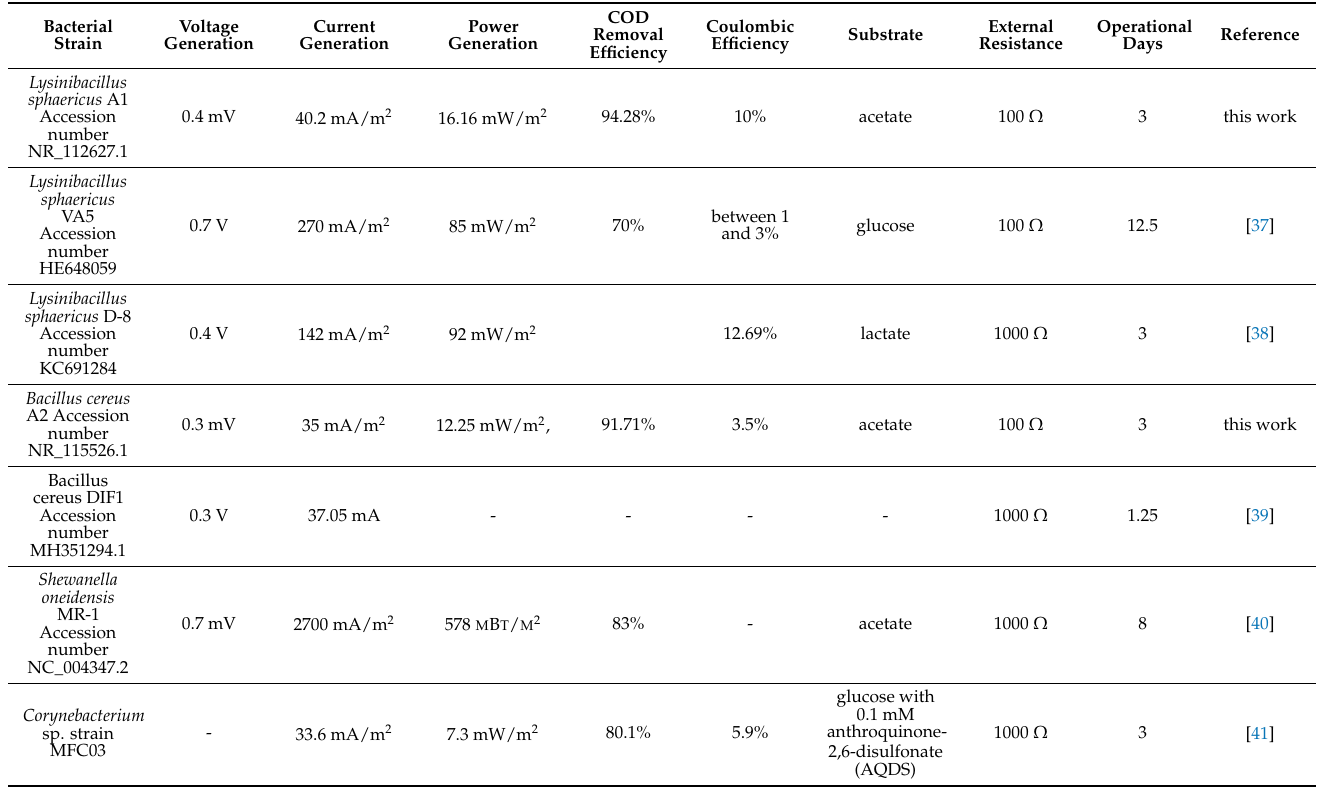
Table 2. Summary of the comparative analysis with known industrial electroactive bacterial strains tested in double-chambered